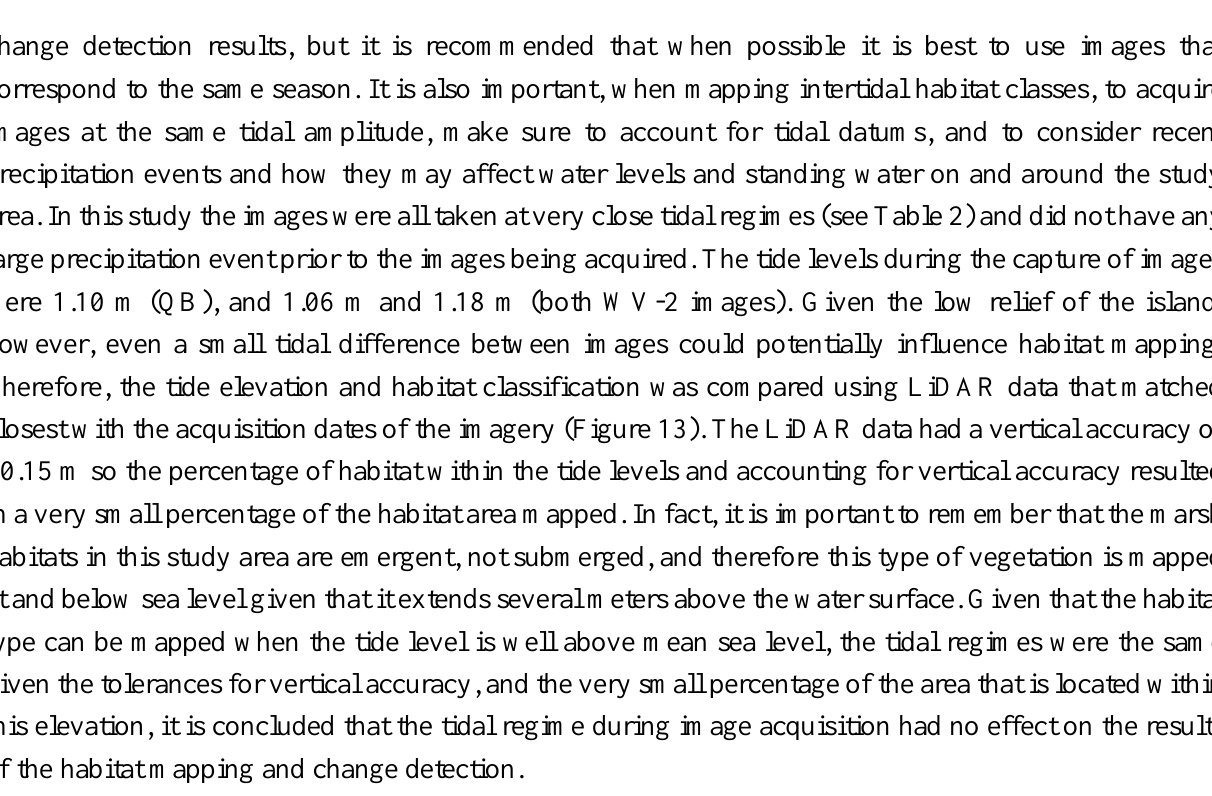
Figure 13. LiDAR elevation data for 2005 (top left) and 2010 (top right) show changes in elevation relative to sea level during this period for a selected area of Masonboro